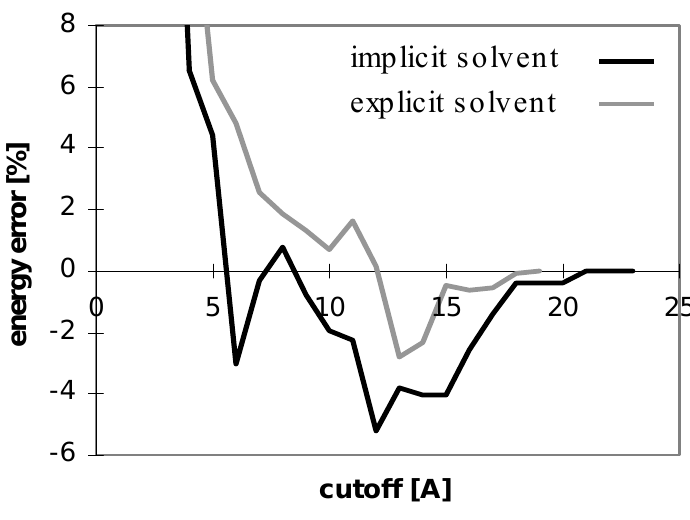
Figure 9. Dependency of electrostatic energy (calculated using cutoff method) on cutoff for implicit solvent and explicit solvent (without including solvent-solvent interactions) for oligonucleotide O4. The same as observed for the absolute energies of the peptides and proteins (see last paragraph of the "Proteins and peptides" section) apply also for the absolute energies of the studied oligonucleotides. Nucleotide-sugars